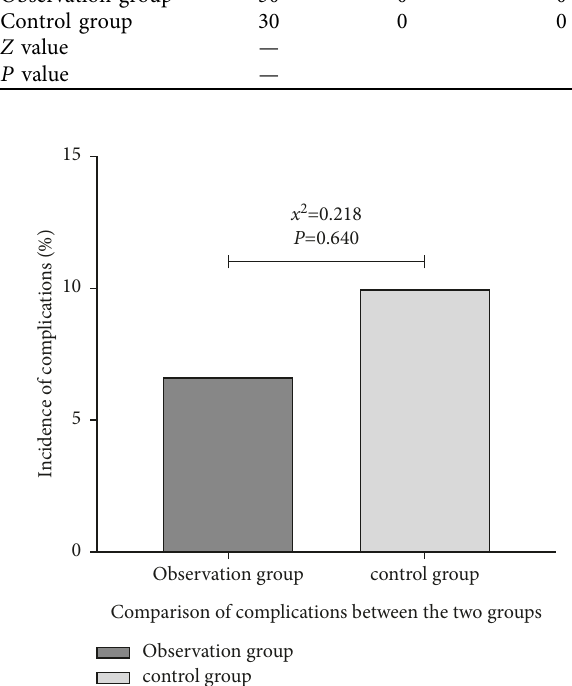
Figure 4: Comparison of complications between the two